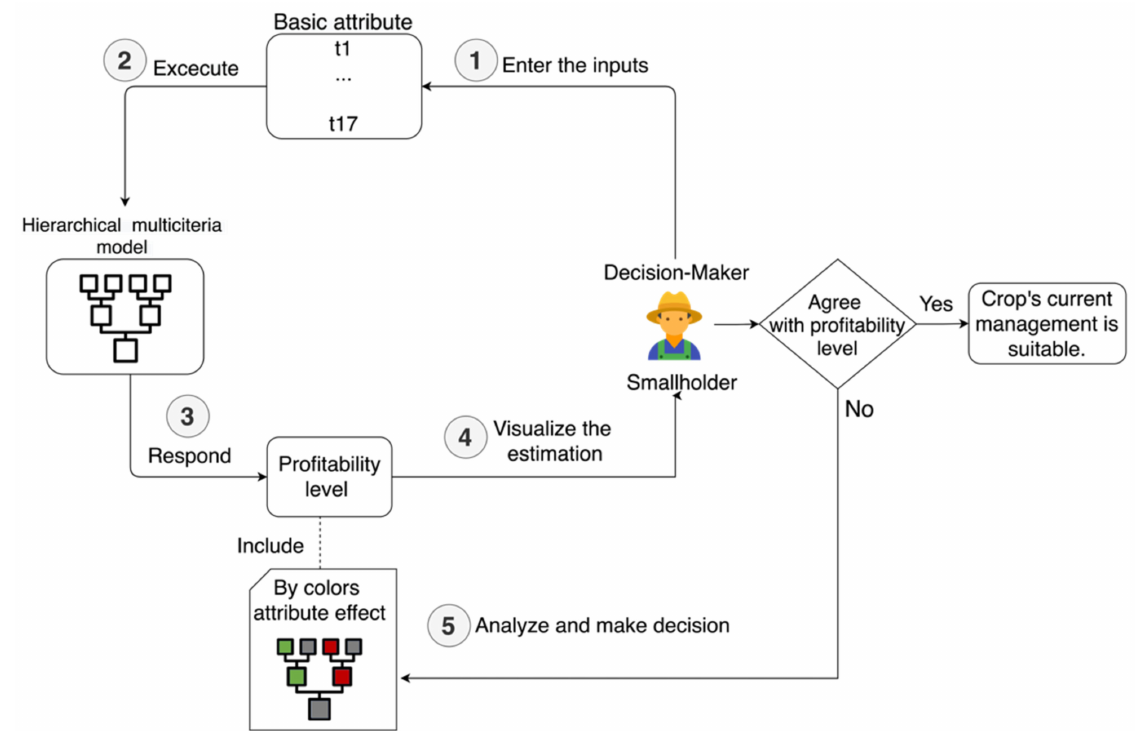
Figure 7. HMP-Coffee practical